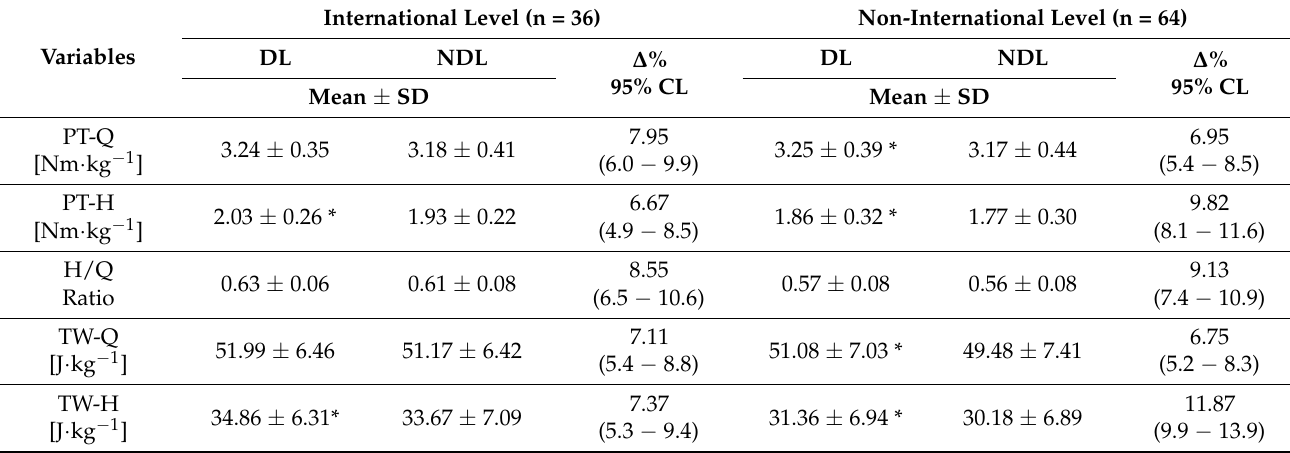
Table 1. Characteristics of the PT of quadriceps and hamstrings, H/Q ratios at 60 ◦ · s − 1 and TW of quadriceps and hamstrings at 240 ◦ · s − 1 angular velocity across soccer player groups. International Level (n = Variables